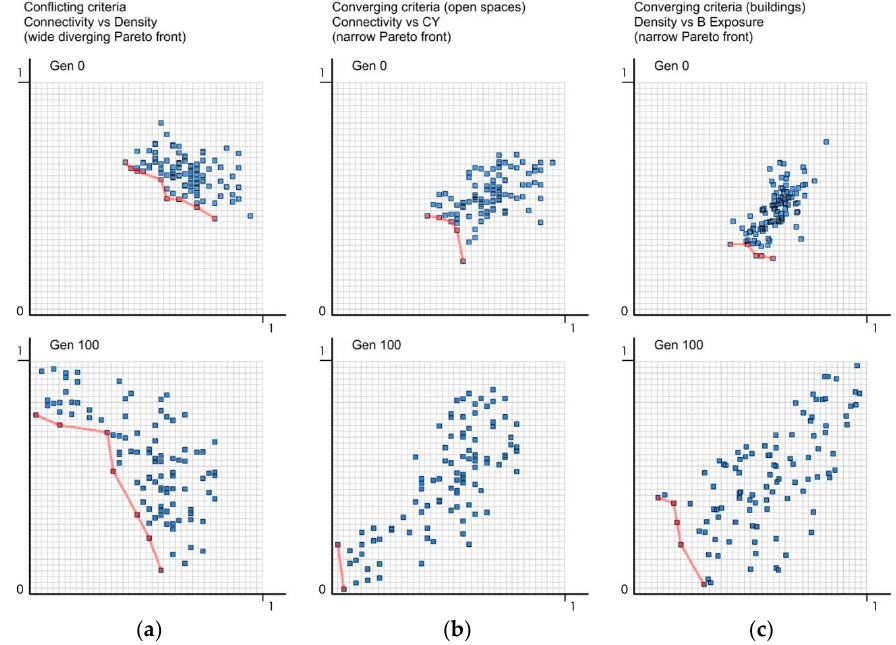
Figure 9. Pareto front analysis for criteria comparison. ( a ) Conflicting criteria for Connectivity and Density; ( b ) converging criteria for Connectivity and CY Exposure; ( c ) converging criteria for Density and B Exposure. Values normalized to the 0 – 1 range for all objectives.